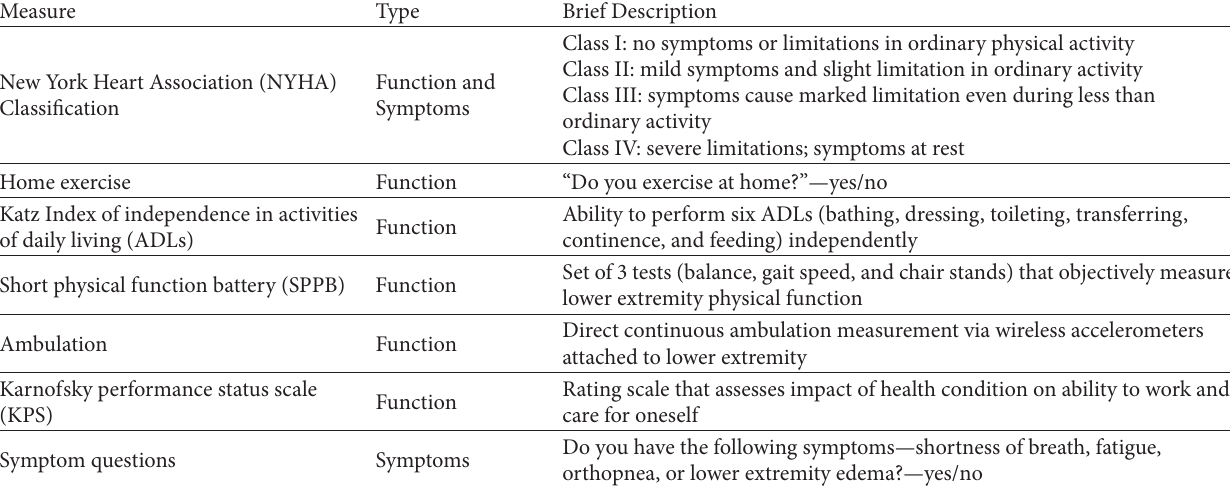
Table 2: Measures of function and